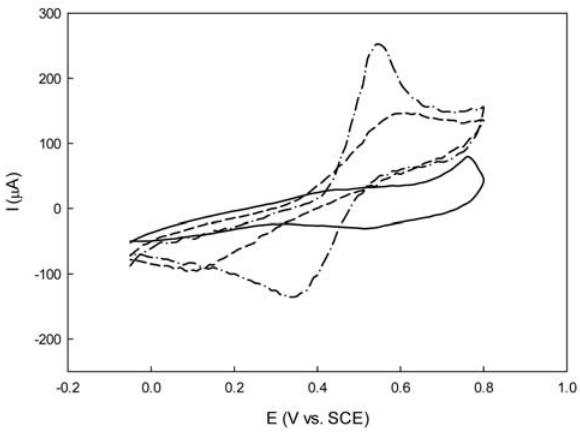
Figure 1. CVs for electro-chemical oxidation of catechol (2.0 mM) in a phosphate buffer solution (pH 3.0) at Pt/PAAQ-SDS modified electrode (dash-dot) and bare Pt electrode (dash-dash). CV for blank phosphate buffer solution (pH 3.0) at modified electrode (so- lid) has been shown for comparison.